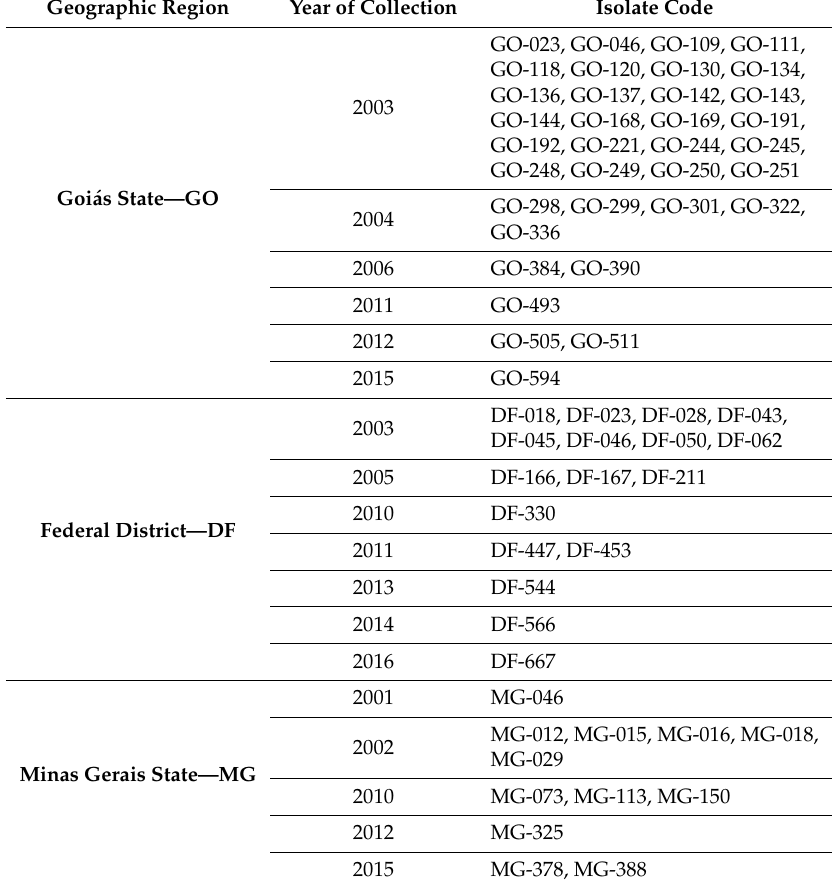
Table 1. Identification of 64 samples ( = isolates) exhibiting begomovirus-like symptoms that were obtained from tomato plants without the Ty -1 gene / locus in central Brazil. Information is provided about the region where the isolate was collected, year of collection, and the respective isolate code.